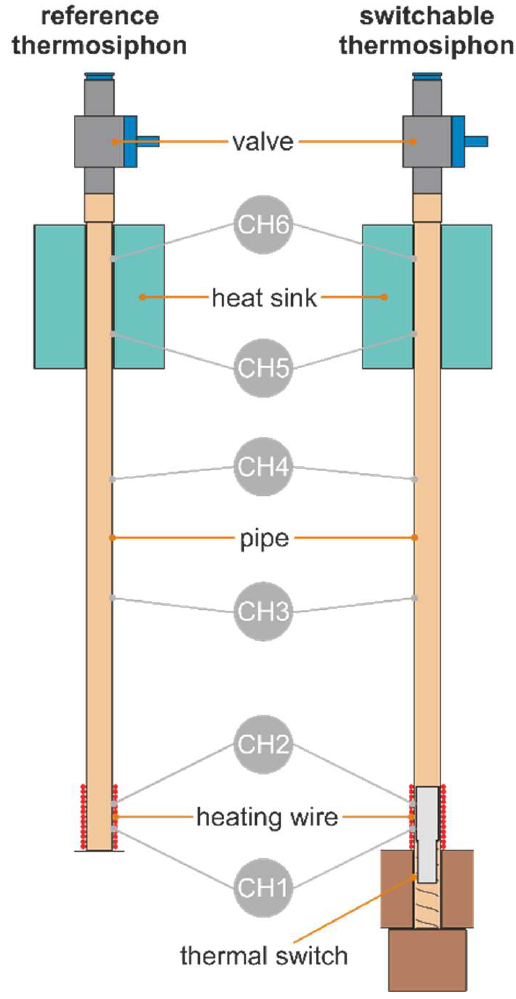
Figure 2. Thermosiphon assemblies and sensor positions.